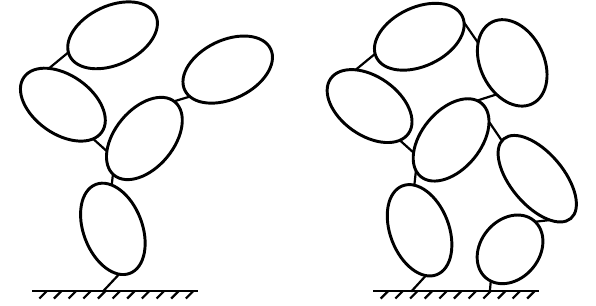
Figure 2. Tree-like versus Closed